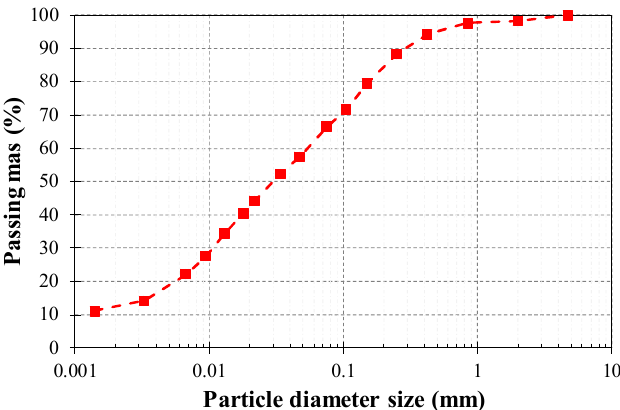
Figure 2. Particle diameter size distribution curve of clayey soil used in this research.